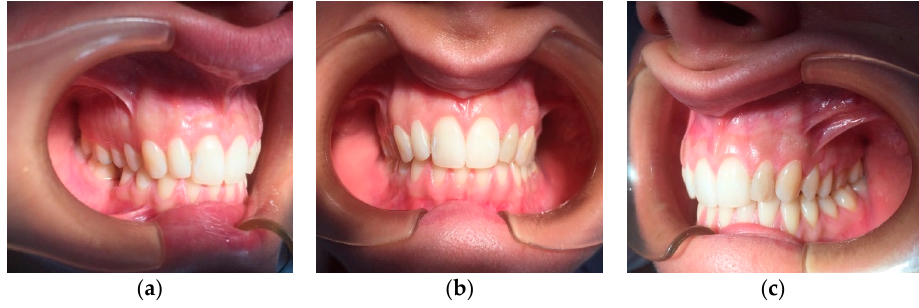
Figure 2. Analysis of the right and left eccentric movement and registration of the maximum range of motion. ( a ) Lateral right excursion of 11 mm; ( b ) Lateral left excursion of 12 mm.